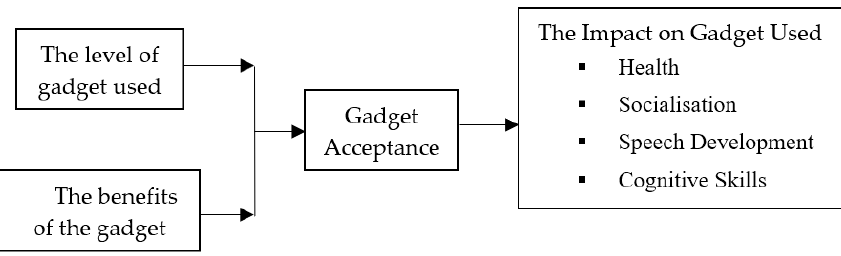
Figure 1. The framework on the gadget acceptance and its impact. Table 1. The use and the impacts on gadget among the children.